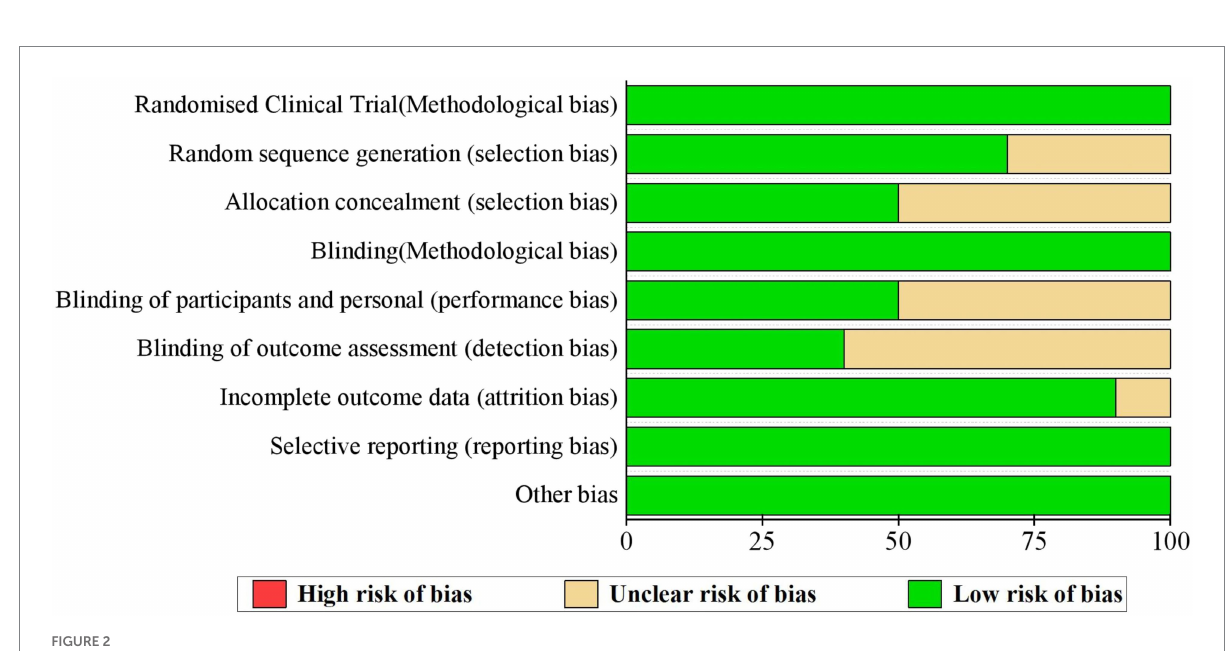
FIGURE 2 Summary of the risk of bias of the 10